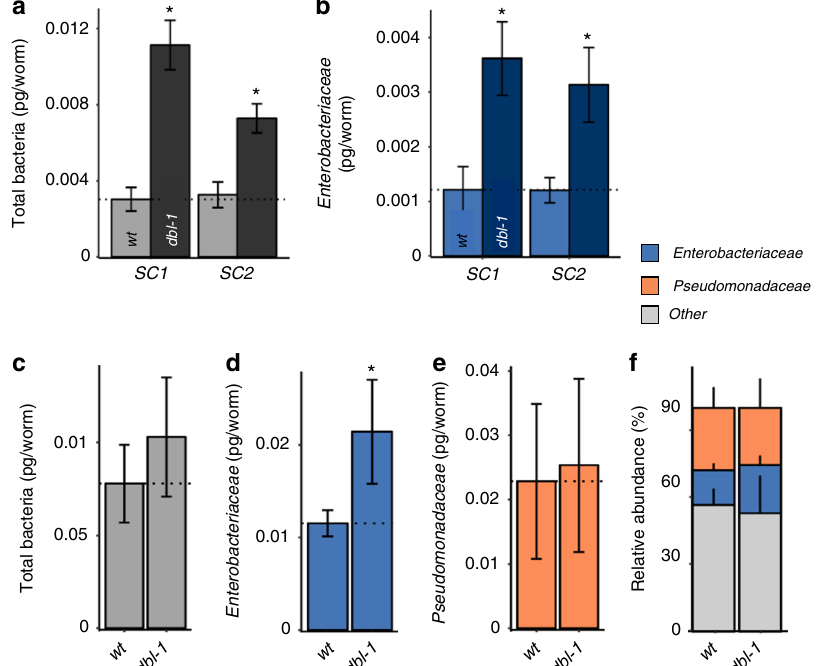
Fig. 2 Enterobacteriaceae expansion in dbl-1 mutants is reproduced in different environments. Total bacterial load ( a ), and abundance of Enterobacteriaceae ( b ) in the gut of wild-type (N2) or dbl-1 worms raised on synthetic communities SC1 or SC2. Shown are averages ± SD of two independent experiments ( n = 30 worms per group per experiment). c – f Total bacterial load ( c ), and abundance of Enterobacteriaceae ( d ) and Pseudomonadaceae ( e ), in worms raised in soil microcosms; f calculated relative abundance, as in Fig. 1. Averages ± SD of four independent populations per genotype ( n = 100 worms per group). * p < 0.05 compared with wild-type animals, t